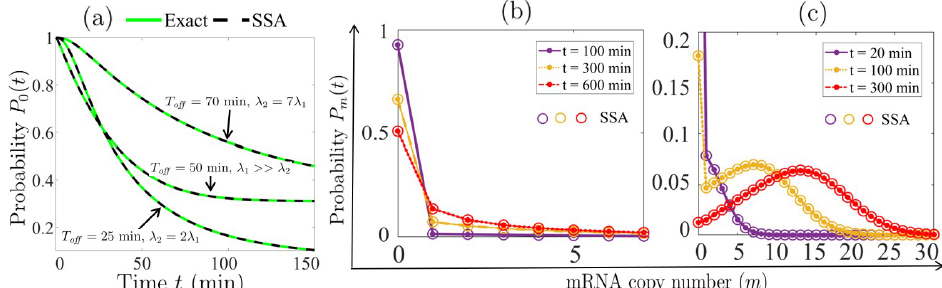
Figure 3. Dynamic profiles of distribution P m ( t ) generated by the derived exact formulas. ( a ) The curves of P 0 ( t ) = V ( − 1, t ) against time t (green lines) are generated using Formulas (13) and (75) under three parameter groups— δ = 0.014, γ = 0.167 (min − 1 ) and T off = 25 min with λ 2 = 2 λ 1 for E.coli P lac/ara promoter[17,40]; δ = 0.0109, γ = 0.167 (min − 1 ) and T off = 70 min with λ 2 = 7 λ 1 for mouse fibroblast genes[22,36]; δ = 0.063, γ = 0.05 (min − 1 ) and T off = 50 min with λ 1 (cid:29) λ 2 for yeast FLO11 gene[11,37]. ( b ) Dynamic decay distribution P m ( t ) (solid circles in lines) of the three-state model generated by the formulas in Theorem 2, with δ = 0.01, λ 1 = λ 2 = δ /2, γ = δ (min − 1 ). ( c ) Dynamic transition among the three modes of distribution P m ( t ) (solid circles in lines) for the two-state model generated by the formulas in Theorem 3, with δ = 0.01, λ 2 = 2 δ , γ = δ (min − 1 ). The black dashed lines in ( a ) and hollow circles in ( b , c ) represent numerical results obtained by the stochastic simulation algorithm. The other parameter is v = 20 δ